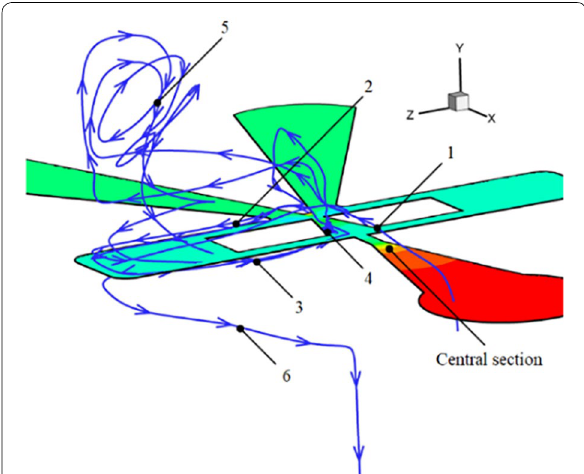
Figure 17 Pressure distribution along the impact surface